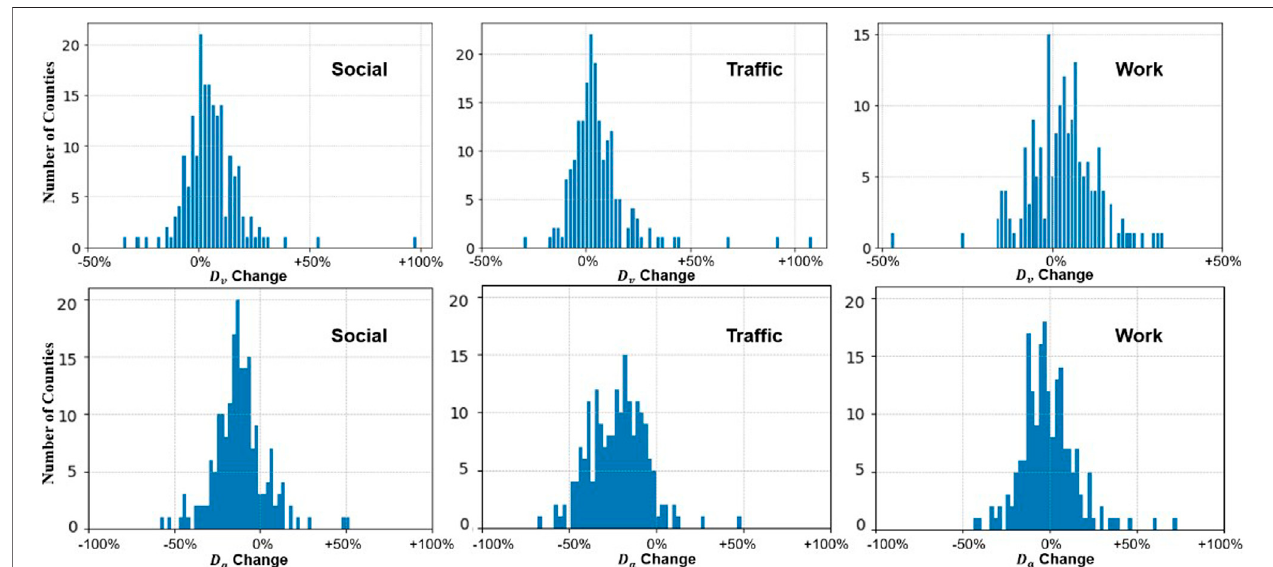
FIGURE 5 | Histogram plots of average percentage change of D v and D a (each row) for three different categories (each column).